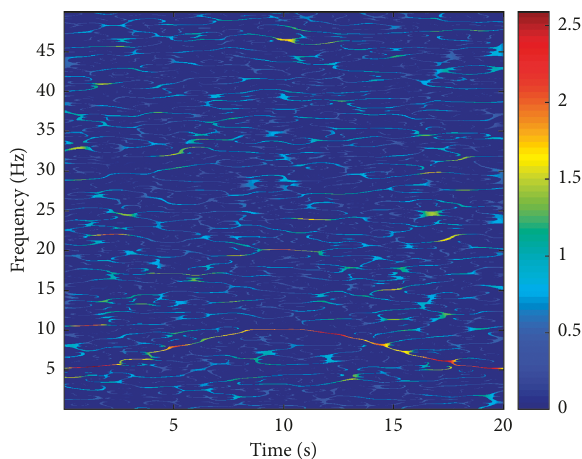
Figure 11: Time-frequency representation of SFM signal based on